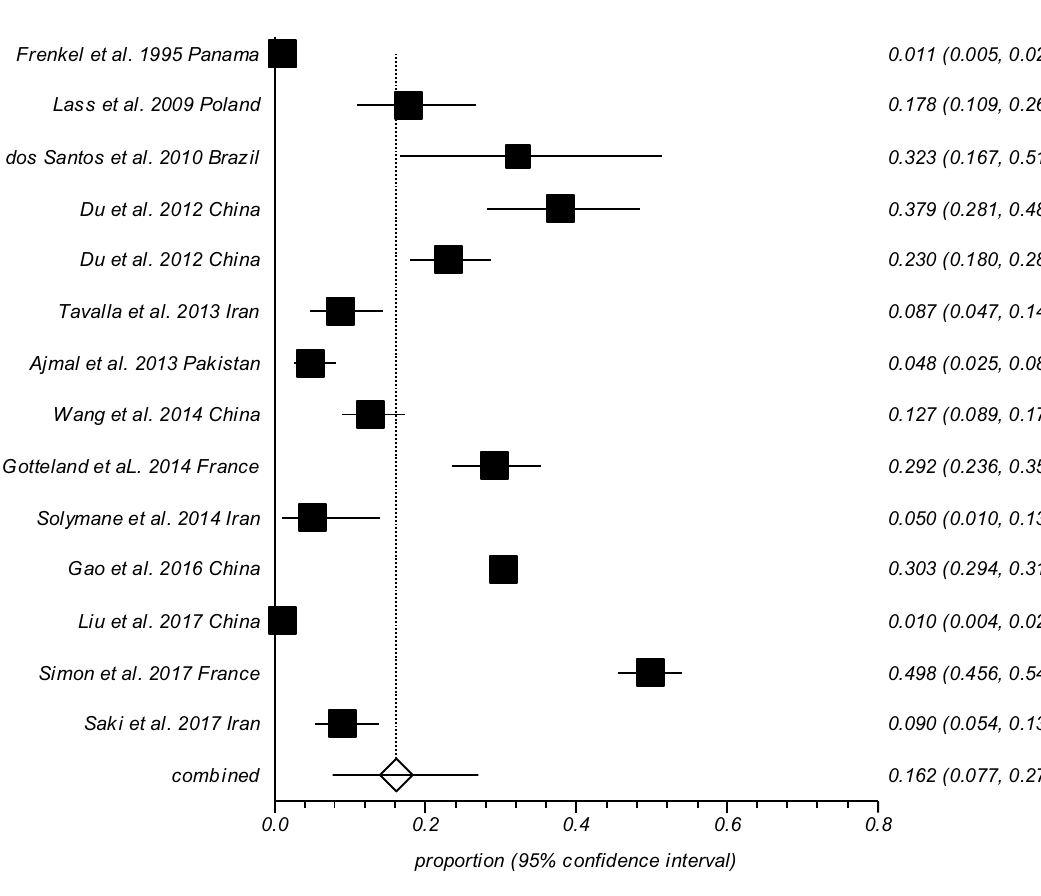
Figure 3. Forest plot diagram of the present systematic review and meta-analysis based on studies focused on detection of soil contamination by Toxoplasma -like